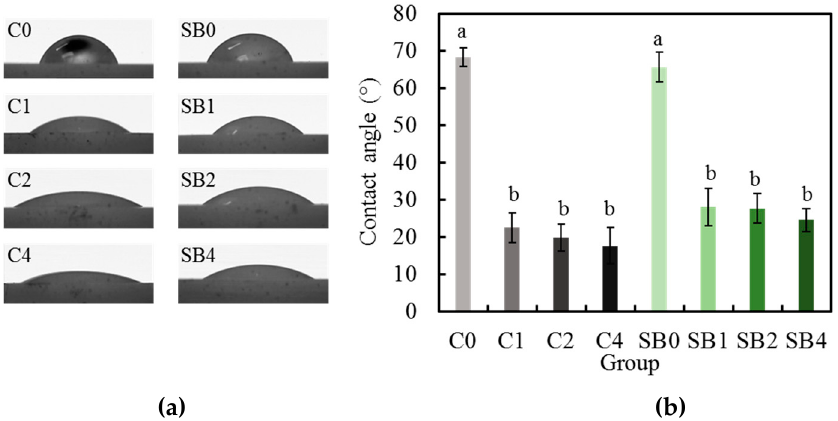
Figure 5. ( a ) Contact angle and images of water droplets on the different specimen surfaces with and without plasma treatments; ( b ) The different characters of “a” and “b” showed significant differences (p < 0.05) (n = 10).